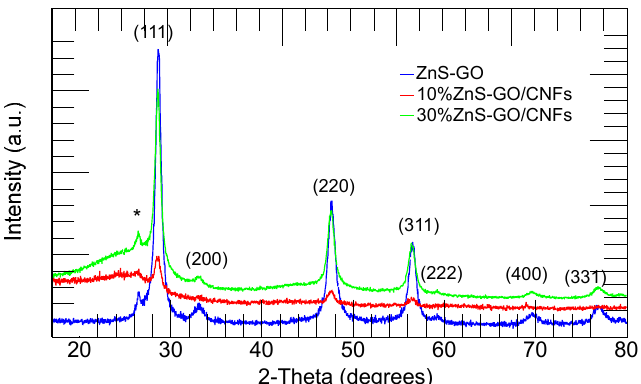
Figure 2. XRPD patterns of the ZnS–GO (blue), 10%ZnS–GO/CNF (red) and 30%ZnS–GO/CNF (green) samples. (002) plane of graphitic carbon (*) and Miller indices of the sphalerite phase are also shown.